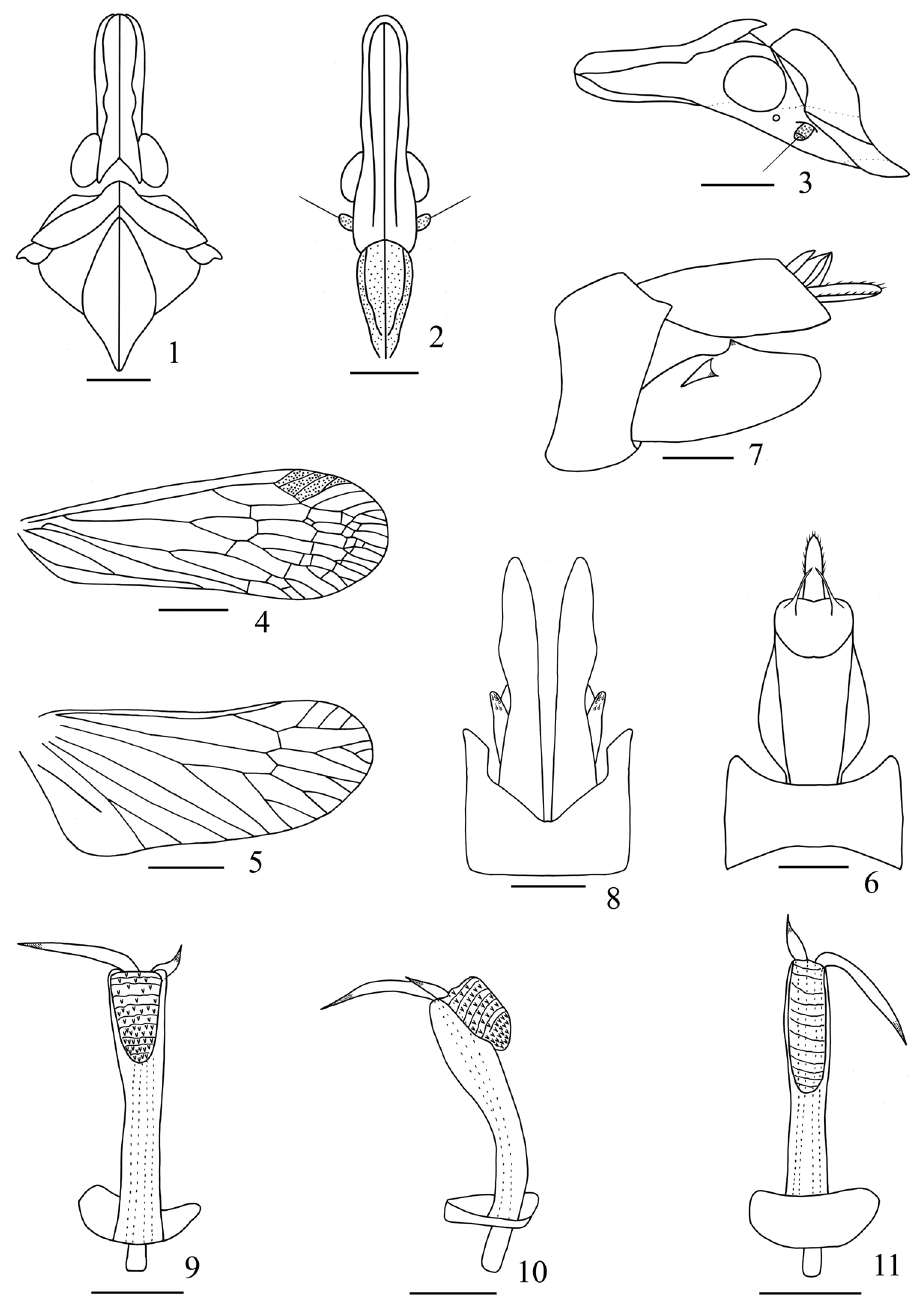
Figures 1–11. Saigona anisomorpha Zheng, Yang & Chen, sp. n. 1 Head and thorax, dorsal view 2 Frons and clypeus, ventral view 3 Head and pronotum, lateral view 4 Forewing 5 Hindwing 6 Pygofer and anal tube, dorsal view 7 Genitalia, lateral view 8 Pygofer and parameres, ventral view 9 Aedeagus, ventral view 10 Aedeagus, lateral view 11 Aedeagus, dorsal view. Scale bars: 1–5 = 1 mm, 6–11 = 0.5